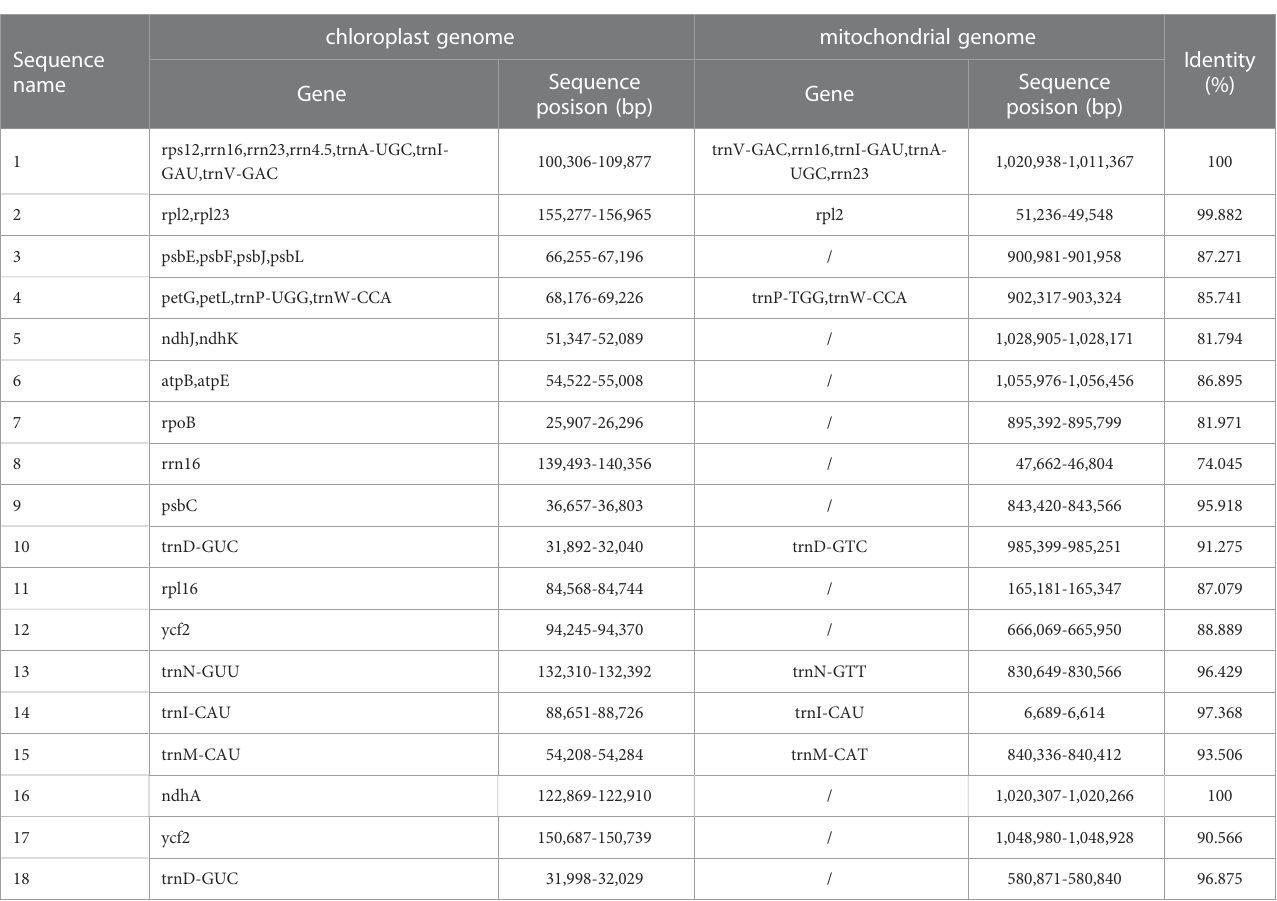
TABLE 3 Plot of ENC of genes in 4 Theaceae species